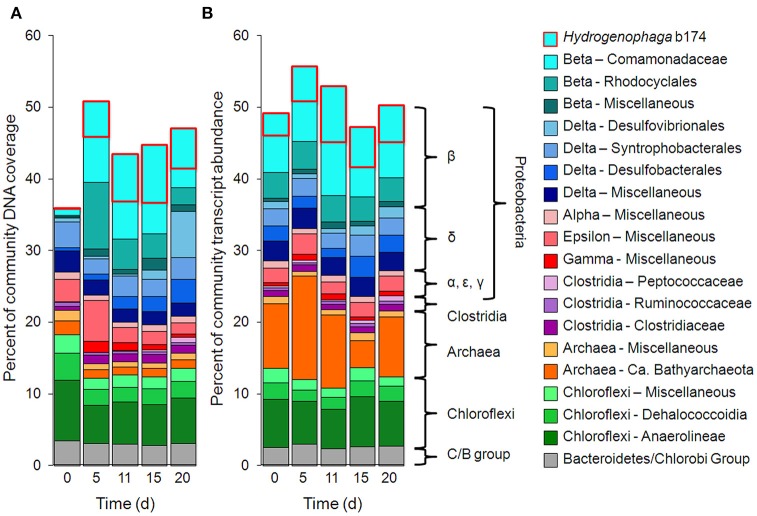
Primary taxa composition. (A) Percent of total community mapped DNA (as depth of coverage) and (B) percent of total community mapped mRNA (as RPKM). Hydrogenophaga b174, belonging to the Comamonadaceae family, is boxed in red.